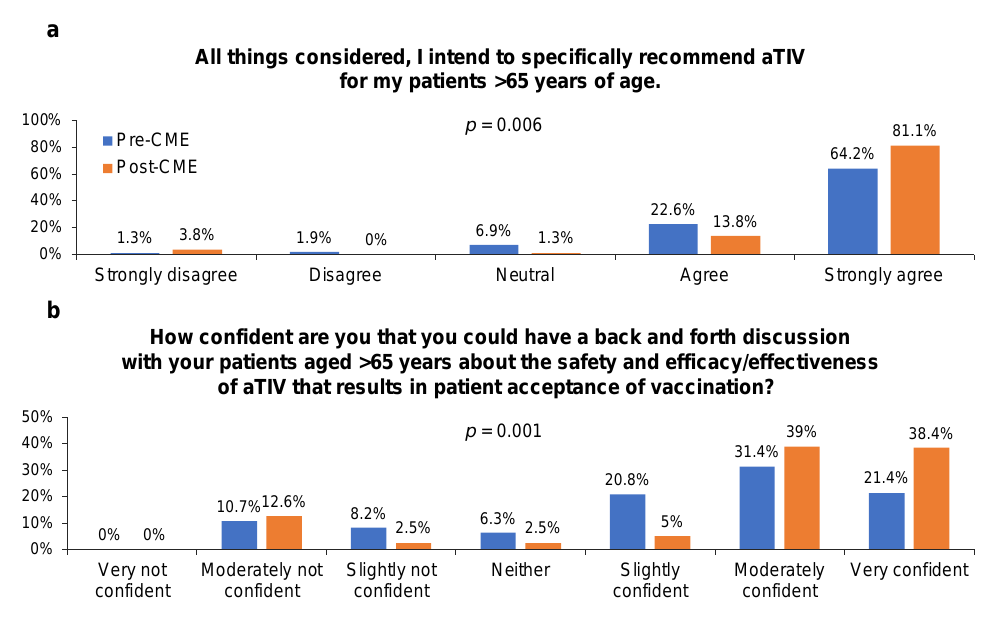
Figure 3. General practitioners’ (n = 159) ( a ) self-reported intention to recommend vaccination with adjuvanted trivalent influenza vaccine (aTIV) for their patients aged ≥ 65 years before and after participating in an accredited continuing medical education (CME) program and ( b ) confidence in their ability to convince patients to accept vaccination with aTIV.